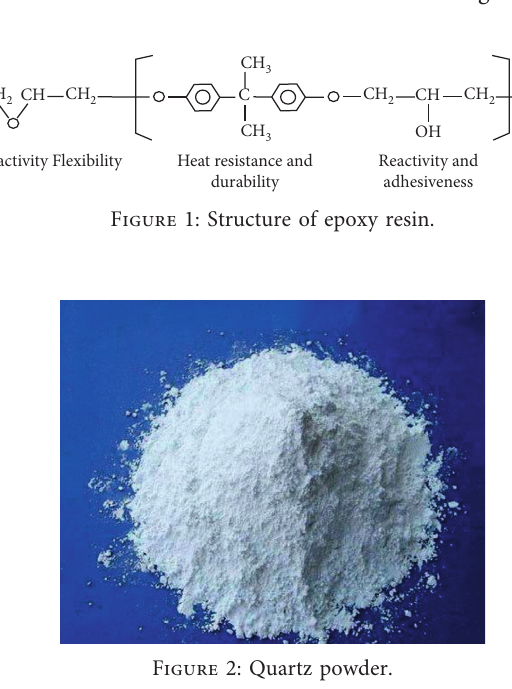
Figure 3: Structure of the quartz